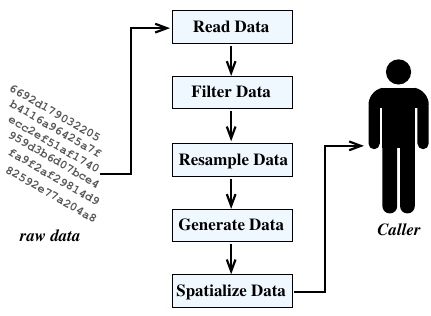
Figure 4. Simplified view of the MeteoIO